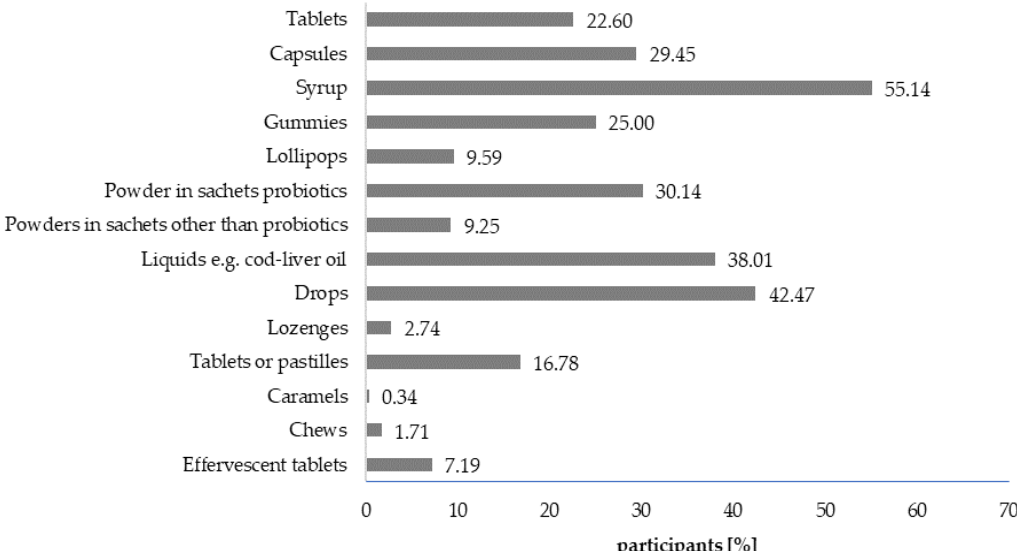
Figure 7. Factors influencing the purchasing decisions made when choosing supplements for children.